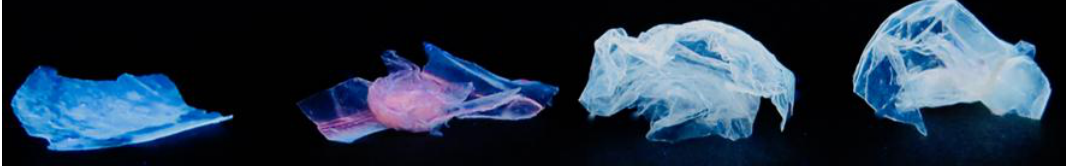
Figure 3. Digital photographs of PS-CF . From left to right: CF , P2-CF , P3-CF and P4-CF under ultraviolet light.